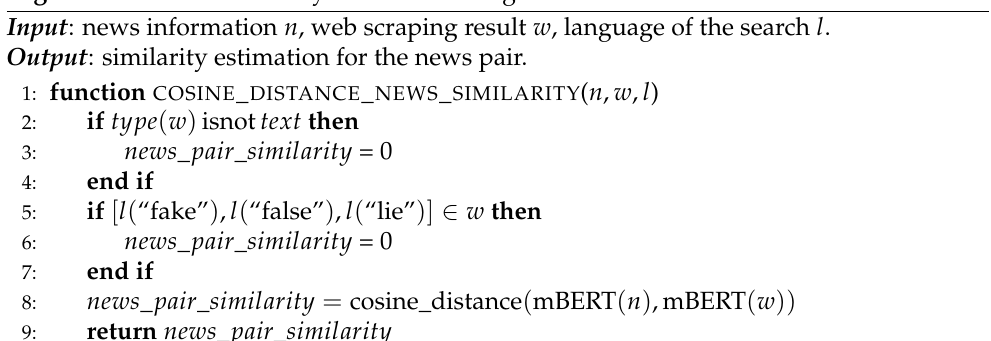
Algorithm 1 News similarity evaluation using cosine distance.